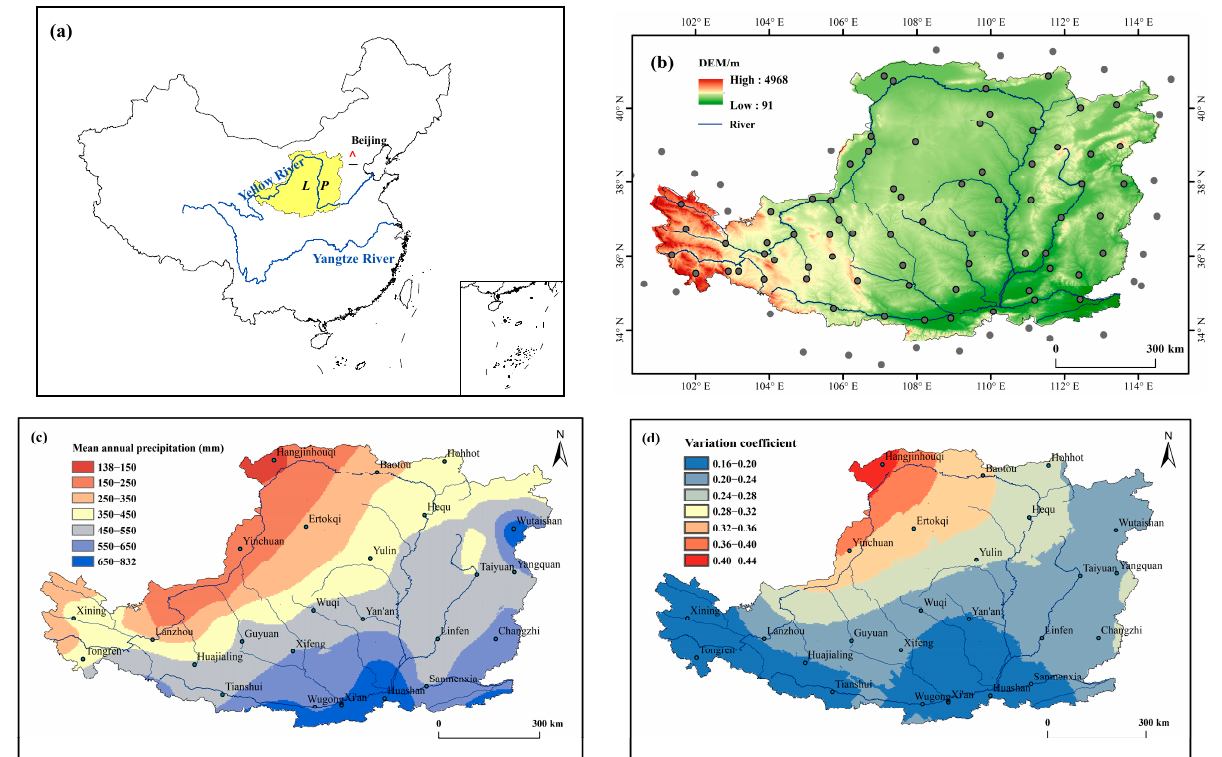
Figure 1. ( a ) The geographical location of the Loess Plateau, ( b ) the digital elevation model map of the study area, ( c ) the distribution of mean annual precipitation, and ( d ) the distribution characteristics of variation coefficient of annual precipitation across the Loess Plateau from 1957 to 2018.